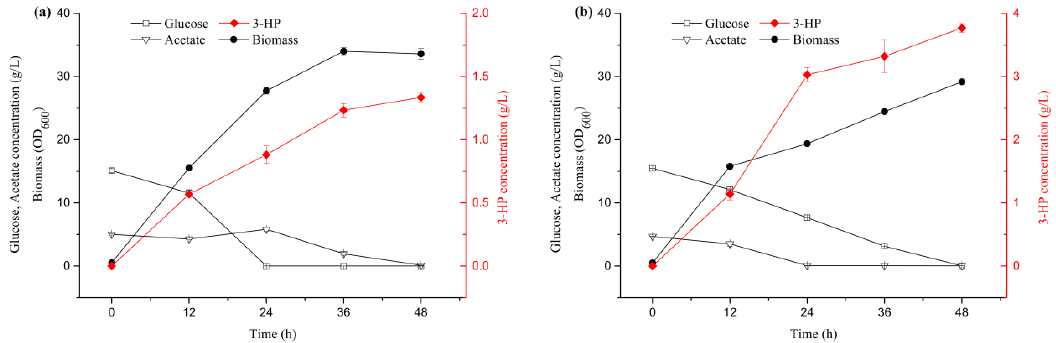
Figure 5. Time profiles of the biomass (filled circles), glucose (open squares), acetate (open downward triangles) and 3-HP (red filled diamonds) concentrations of strain Cgz5 grown in medium with an initial 15 g/L glucose and 5 g/L acetate ( a ) without cerulenin, and ( b ) with 10 μM cerulenin being added at 6 h. Error bars indicate the standard deviations from three independent cultures.